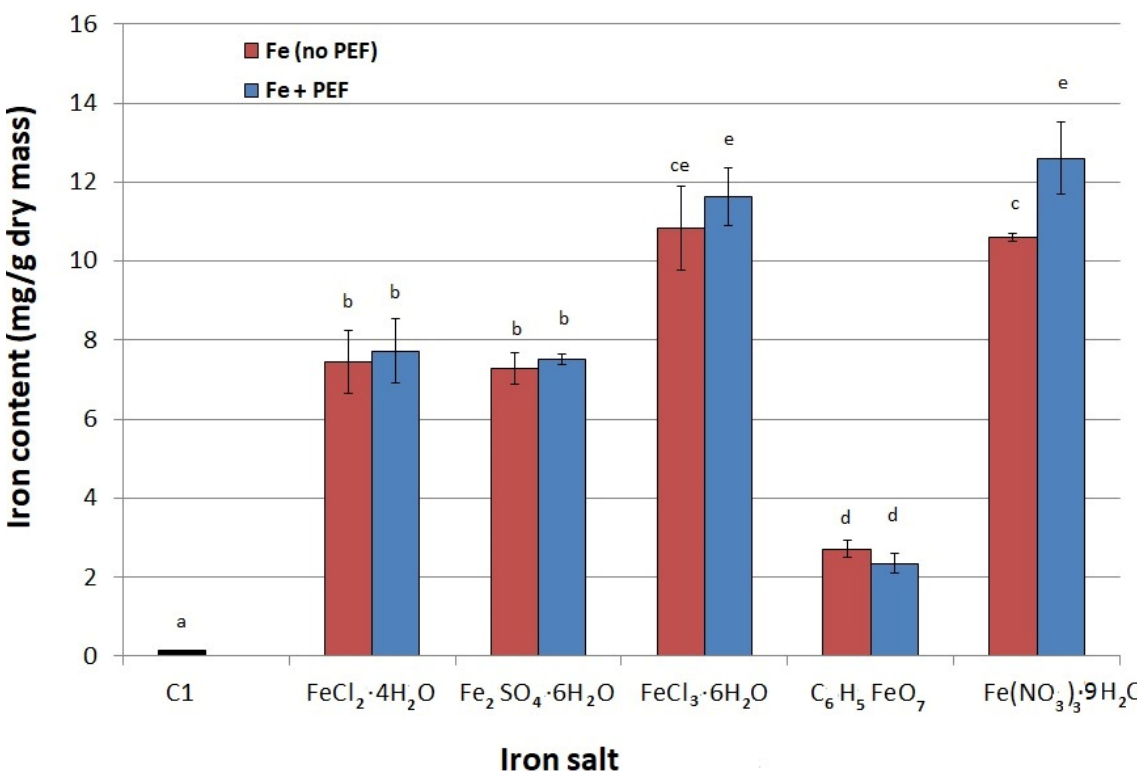
Figure 1. Effect of iron salt on iron accumulation in yeast cells: C1—control culture without iron ions added to the medium and PEF treatment; red bars—cultures not treated with PEF, blue bars—cultures treated with PEF (100 µ g Fe/mL medium, voltage of 1500 V, pulse width of 10 µ s, treatment time 10 min, number of pulses 600, after 20 h of cultivation). Each value is the mean ± standard deviation ( n = 3). Bars with the same letter (a–e) are not significantly different ( p < 0.05).